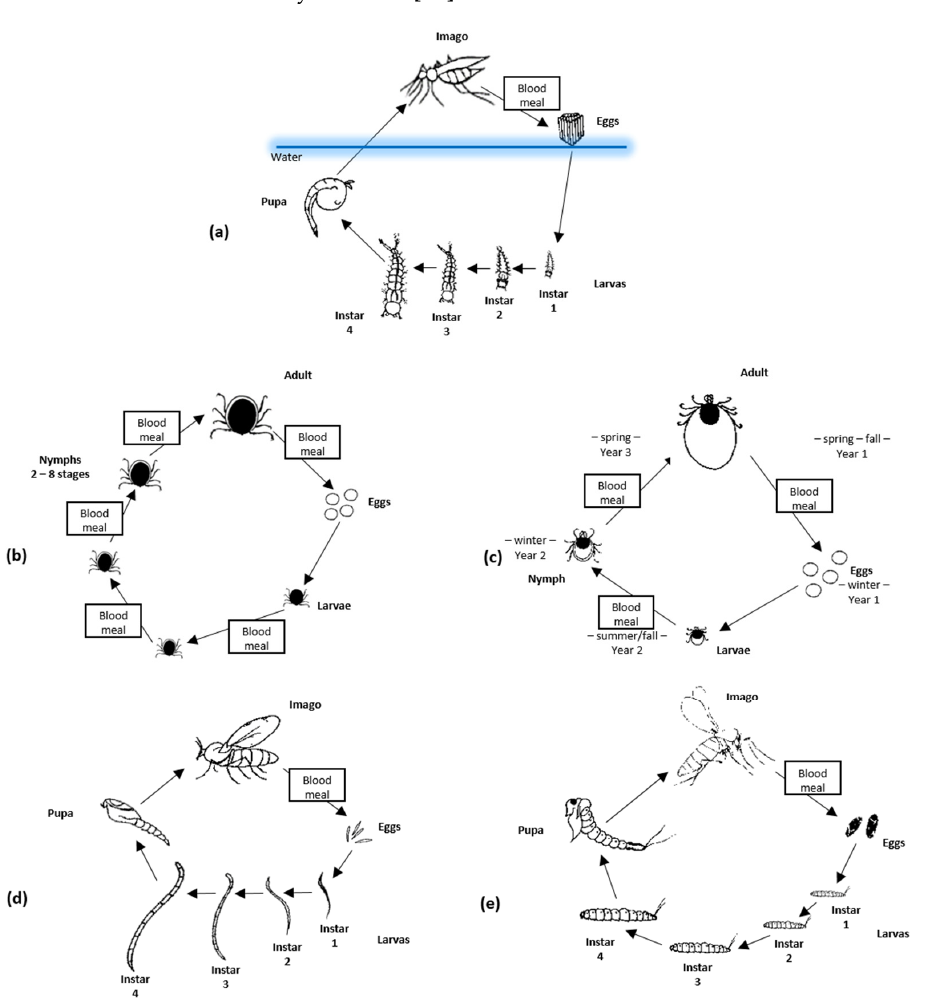
Figure 1. Life cycle of mosquitoes ( a ), soft ticks ( b ), hard ticks ( c ), biting midges ( d ), and sandflies ( e ). 4.2. Ticks Ticks are obligatory, blood-feeding ectoparasites of human and other vertebrates